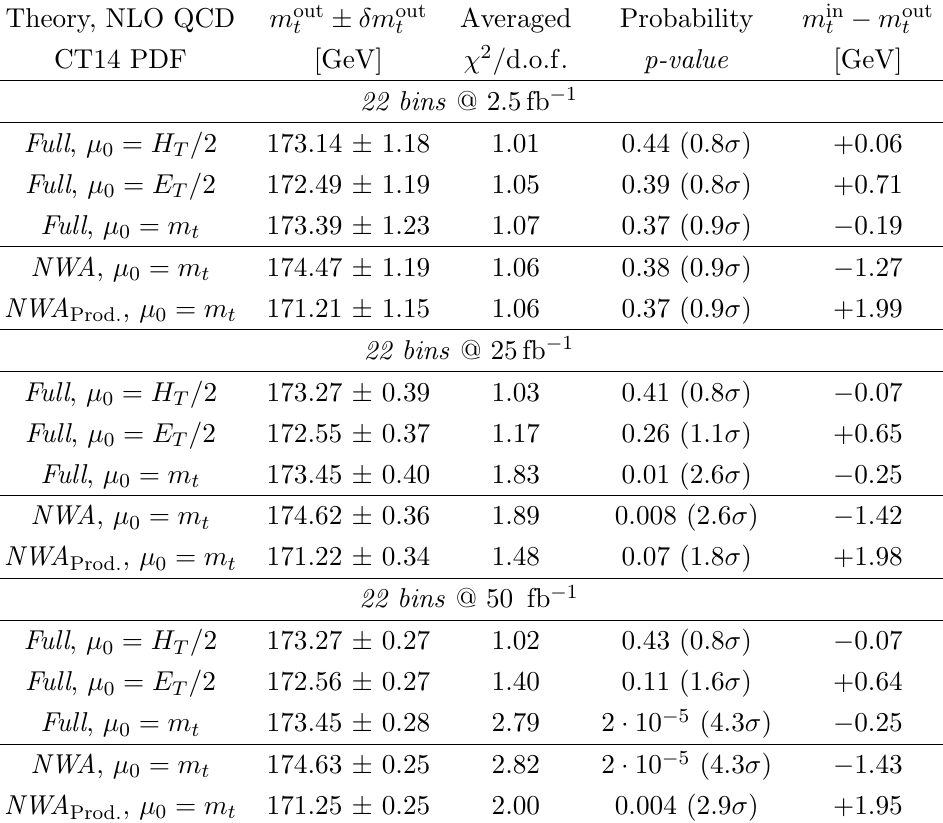
Table 8 . Mean value of the top quark mass, m out , from 1000 pseudo-experiments as obtained from t the normalised H T di(cid:11)erential distribution for the pp e + (cid:23) e (cid:22) (cid:0) (cid:22) (cid:23) (cid:22) b (cid:22) bj + X production process at ! the LHC with p s = 13 TeV. Also shown is 68 % C.L. (1 (cid:27) ) statistical error of the top quark mass, (cid:14)m out , together with the averaged minimal (cid:31) 2 =d:o:f and the p-value. The number of standard t deviations corresponding to each p-value is presented in parentheses. In the last column the top quark mass shift, de(cid:12)ned as m in m out , with m in = 173.2 GeV, is also given. Luminosity of 2.5 fb (cid:0) 1 , t (cid:0) t t 25 fb (cid:0) 1 and 50 fb (cid:0) 1 is